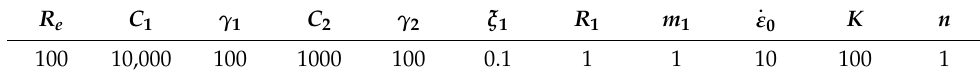
Table 2. Example of a chromosome with real values for genes.